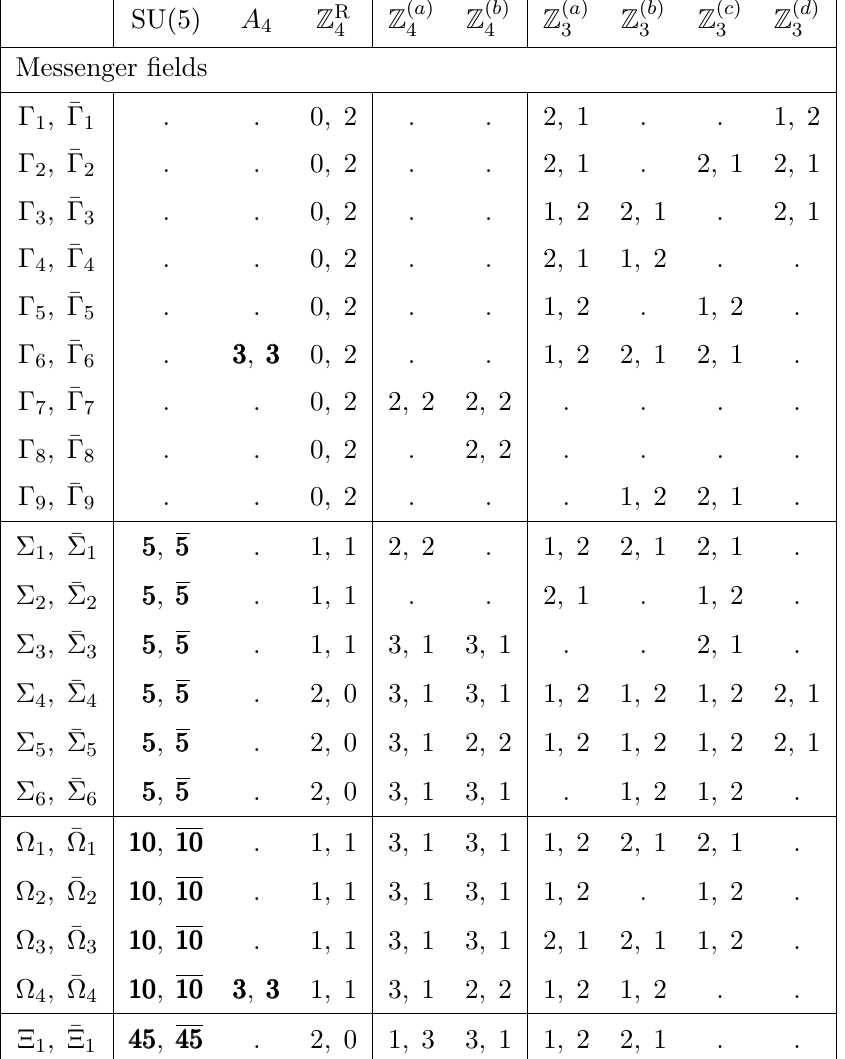
Table 5 . The messenger (cid:12)eld content of our model. A dot means that the (cid:12)eld is an invariant singlet under the respective